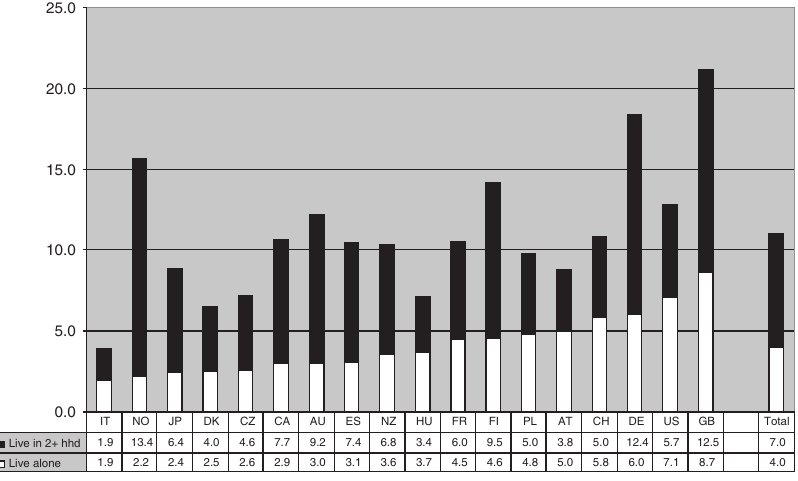
Figure 4. Proportion of all respondents ha v ing infrequent (less than monthly) contact with an adult child or sibling, by household type and country. n (cid:4) 9942 (includes those with no li v ing relati v e and missing cases as no